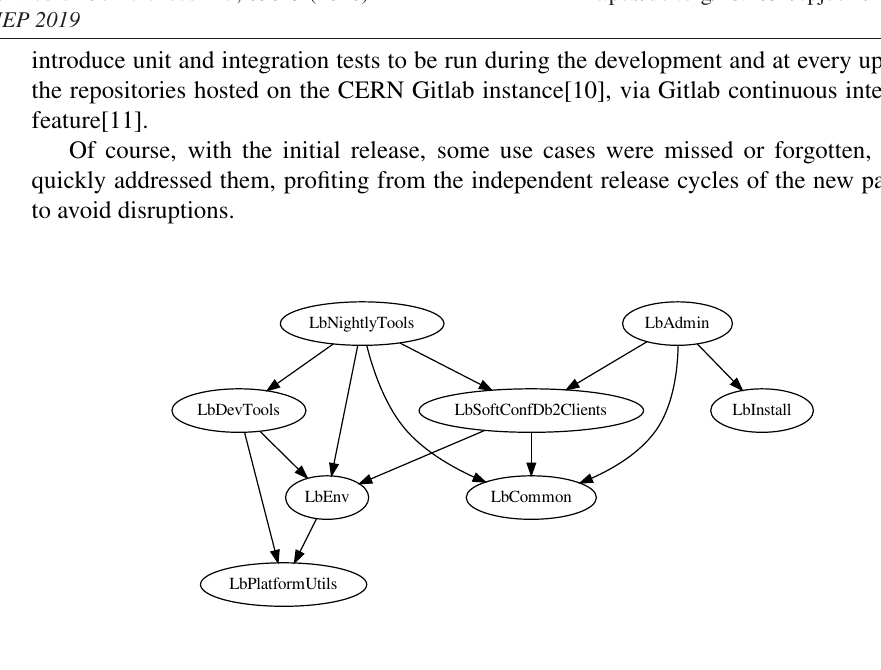
Figure 1. Example of interdependencies of some of the new LHCb Python packages. For example, LbPlatformUtils is used for host CPU architecture detection and compatibility support, LbEnv pro- vides tools to set up the runtime environment of LHCb Physics Applications, LbDevTools contains scripts and resources to support building the software, and LbAdmin provides tools for maintenance of infrastructure and